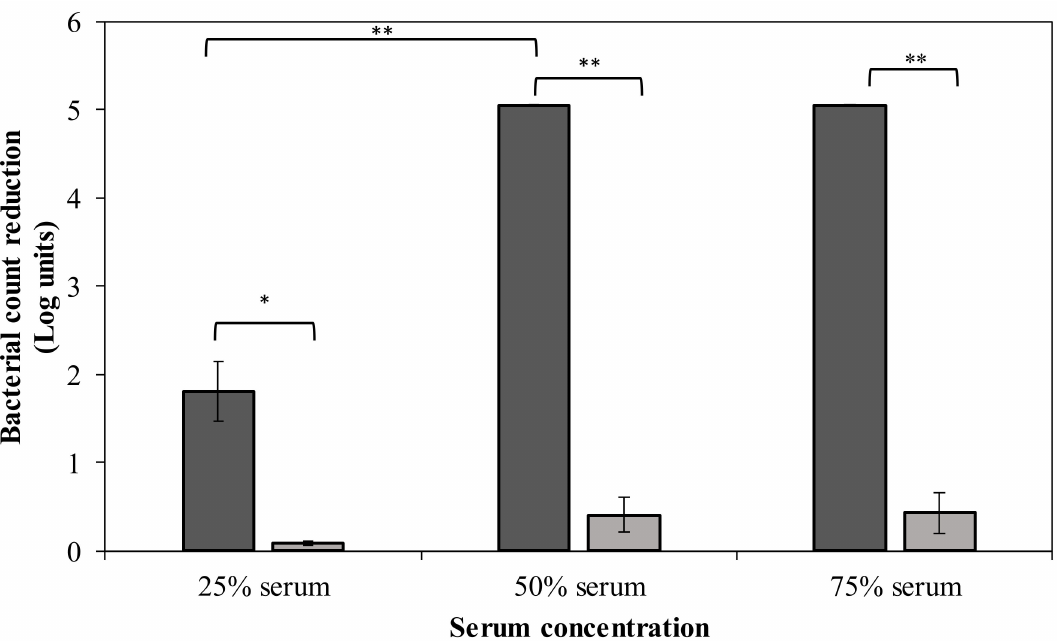
Figure 9. Sensitization to serum after DpoMK34 pretreatment. Exponentially growing A. baumannii MK34 cells are pelleted and diluted to 10 6 CFU/mL using PBS pH 7.4. The cells were then treated with 100 µ g/mL DpoMK34 for 2 h in 35 ◦ C, washed and subjected to different serum concentrations [expressed in % ( v / v )], followed by a 2 h incubation at 37 ◦ C for 2 h. The bacterial cell count was subsequently determined. Both the effect of normal human serum (dark grey) and heat-inactivated serum (56 ◦ C; 30 min) serum (light grey) were evaluated. Bars represent means ± standard deviation of three independent replicates. Asterisks show statistical differences compared to treatment in heat- inactivated serum, or between different serum concentrations (Student’s t -test; * p < 0.05, ** p <